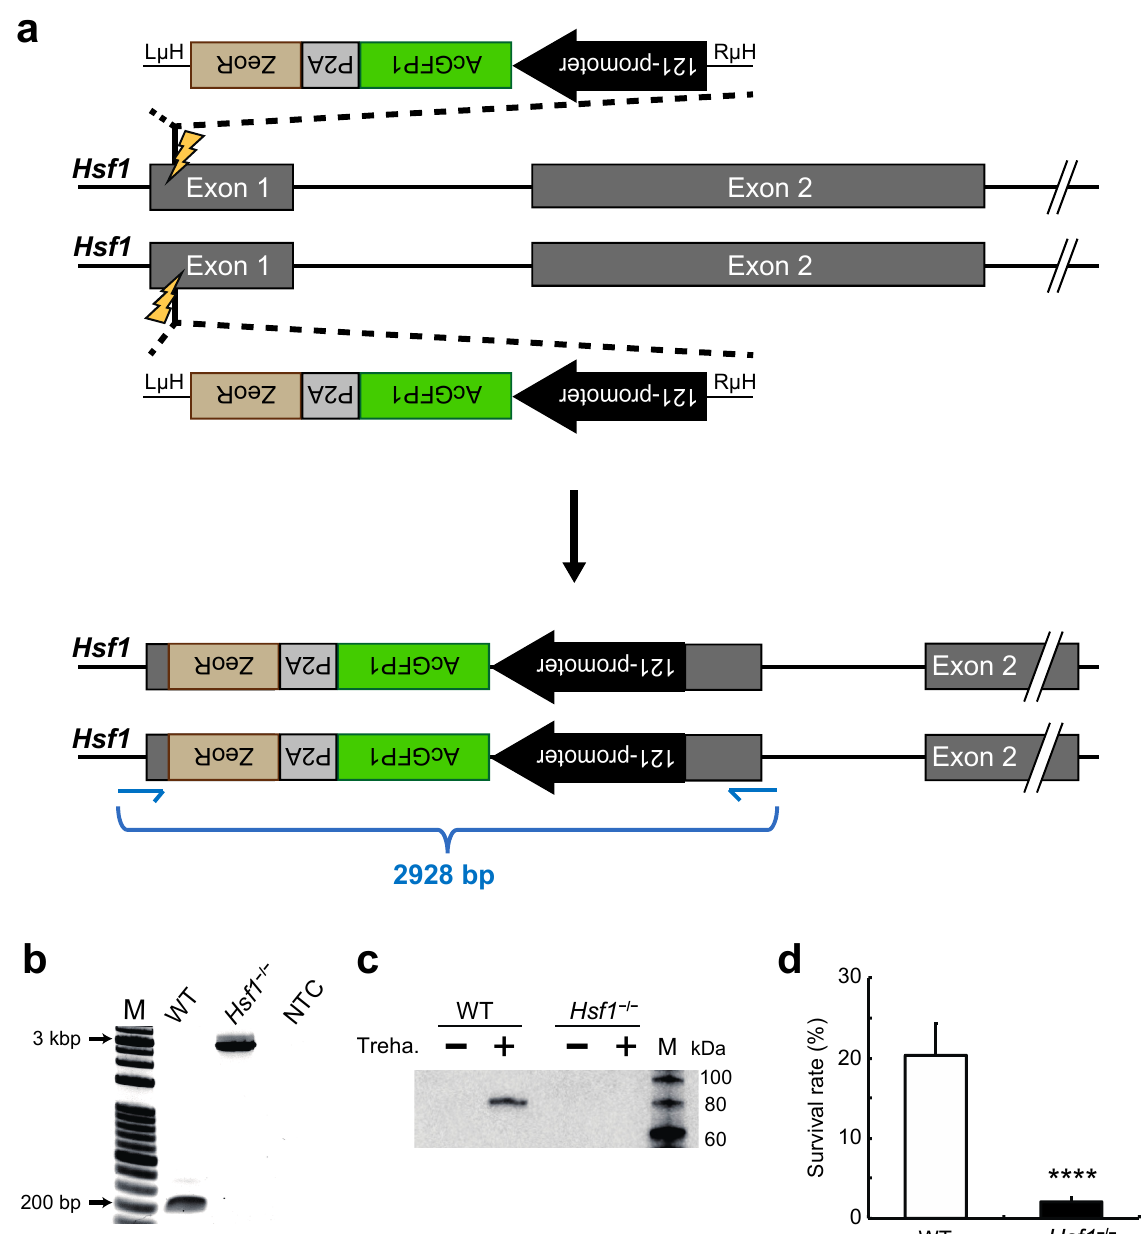
Figure 1. Establishment of an HSF1-knockout ( Hsf1 − / − ) cell line: ( a ) Schematic diagram of Hsf1 knockout in Pv11 cells using the CRIS-PITCh (CRISPR/Cas9-mediated precise integration into target chromosome) system. The donor vector harbors 121-promoter-AcGFP1-P2A-ZeoR sequences flanked by microhomology arms and was transfected with gRNA- and hSpCas9-expression vectors into Pv11 cells, resulting in insertion of the AcGFP1 and ZeoR expression units into exon 1 of Hsf1 . The thin blue arrows show the primer binding sites for the genomic PCR shown in ( b ). The primer sequences are given in Data S1. L μ H and R μ H, left and right microhomology, respectively; ( b ) PCR analysis of ZeoR + and AcGFP1 + clonal cell line. The product sizes of the WT and the clonal cell line are 191 bp and 2928 bp, respectively. The sequence is given in Data S1. WT, wild type Pv11 cells; M, molecular size markers; NTC, no-template control; ( c ) Western blotting analysis of the Hsf1 − / − clonal cell line using HSF1 antibody. The same membrane stained with ponceau S to validate protein transfer is shown in Figure S2. Treha., treatment for 48 h with trehalose mixture; ( d ) survival rate after desiccation-rehydration of the Hsf1 − / − clonal cell line. The number of live cells was counted one day after rehydration. Normalized values are expressed as mean ± standard deviation (SD). **** p < 0.0001; n = 6 in each group.